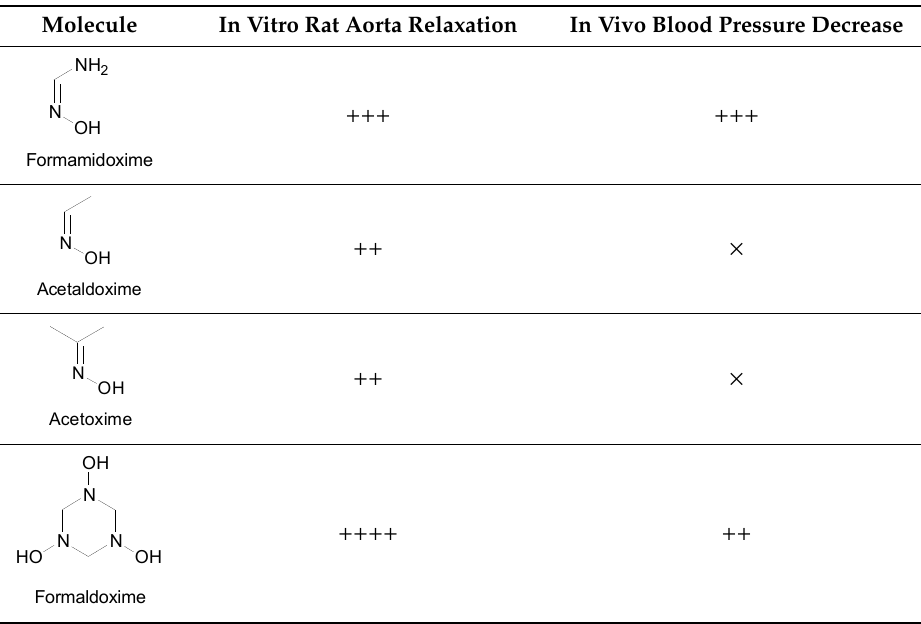
Table 6. Comparison of some studied amidoximes and oximes for their aorta relaxation and pressure decrease abilities.